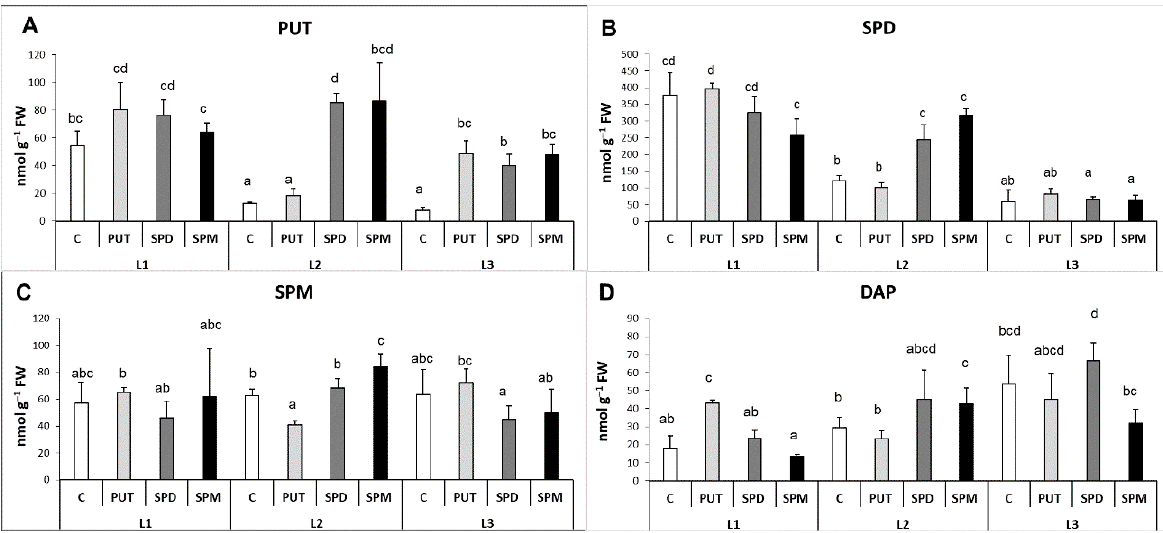
Figure 4. Effect of different light intensities on the polyamine pattern ( A : PUT: putrescine, B : SPD: spermidine, C : SPM: spermine, D : DAP: 1,3-diaminopropane) in the leaves of plants grown under 16 h/8 h day/night light period with different light intensity conditions: 500 (elevated light: L1), 250 (medium light: L2) and 50 (low light: L3) μ mol m 2 s − 1 LED light after 7 days of 0.3 mM exogenous putrescine (PUT), spermidine (SPD) or spermine (SPM) treatments or without any treatment (C). Data represent mean values ± SD. Different letters indicate significant differences at p ≤ 0.05 level, among all the values of the given compounds.